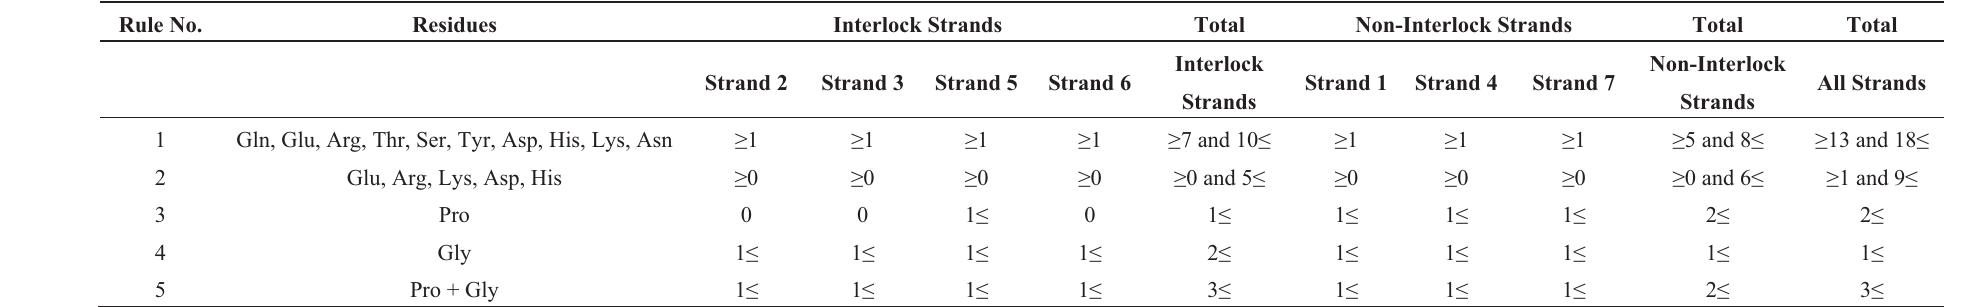
Table 2. The rules of assignment of residues at hydrophilic positions in